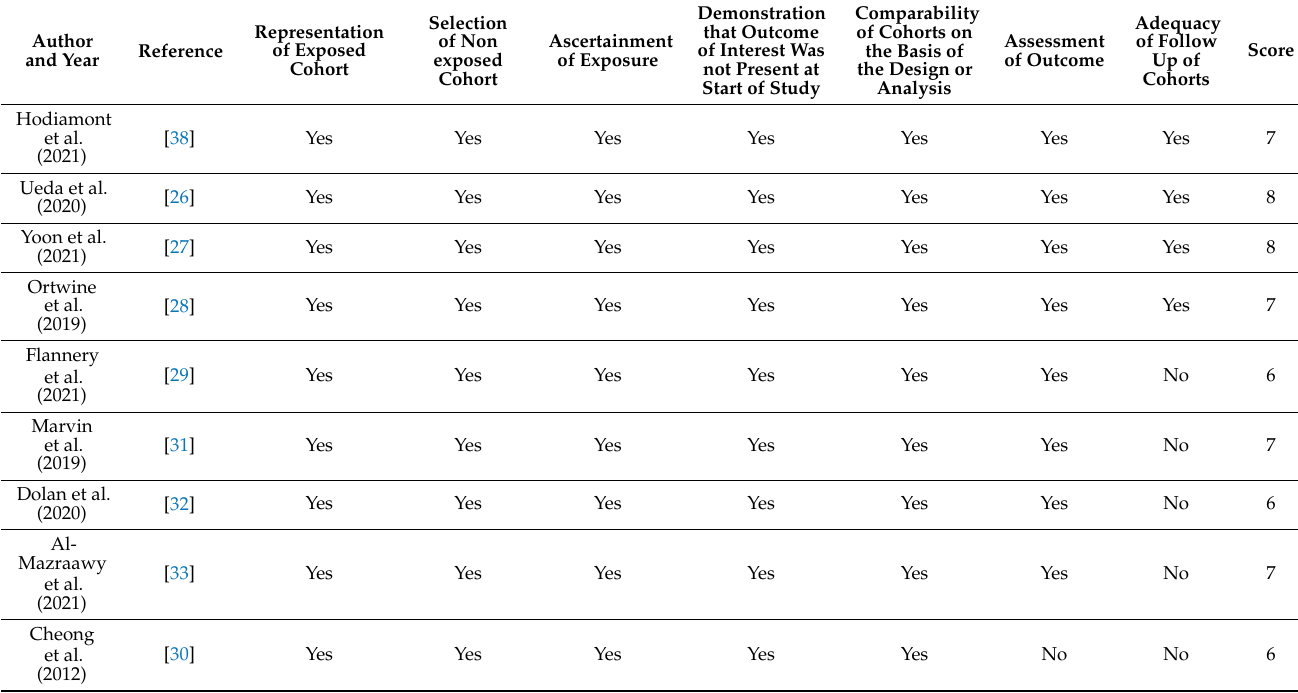
Table 2. Quality assessment of cohort